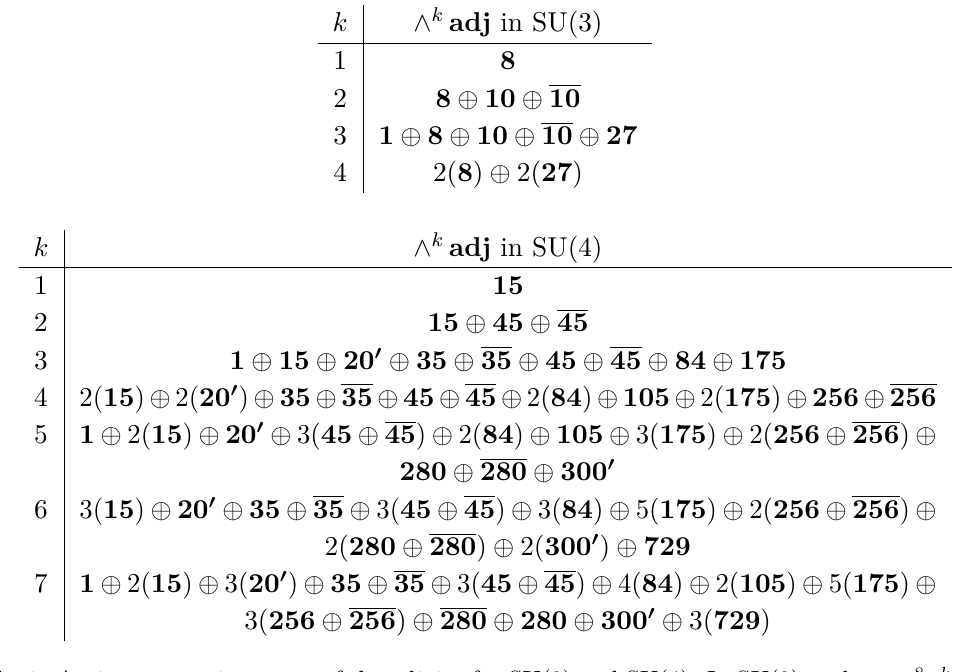
Table 1 . Antisymmmetric powers of the adjoint for SU(3) and SU(4) . In SU(3) we have ∧ 8 − k adj = ∧ k adj , and in SU(4) we have ∧ 15 − k adj = ∧ k adj